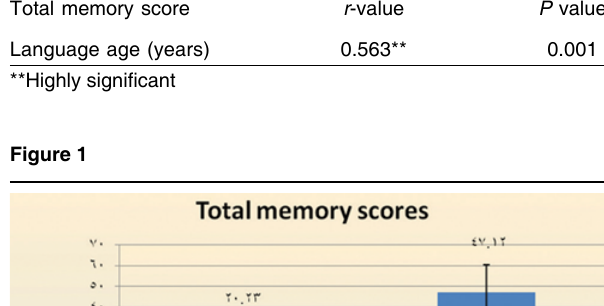
1Table 5 Correlations of total memory scores with language age Total memory